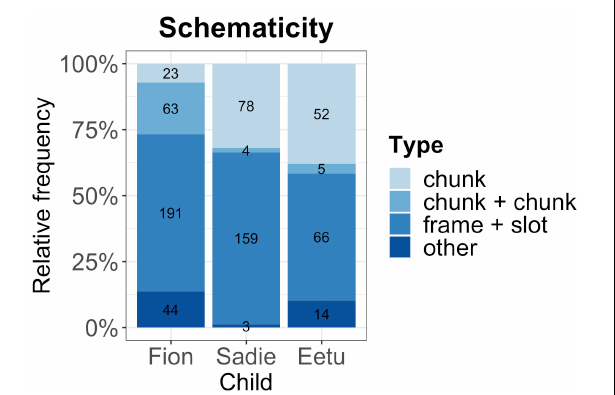
FIGURE 1 | Schematicity in code-mixing. Numbers in the bars indicate the number of